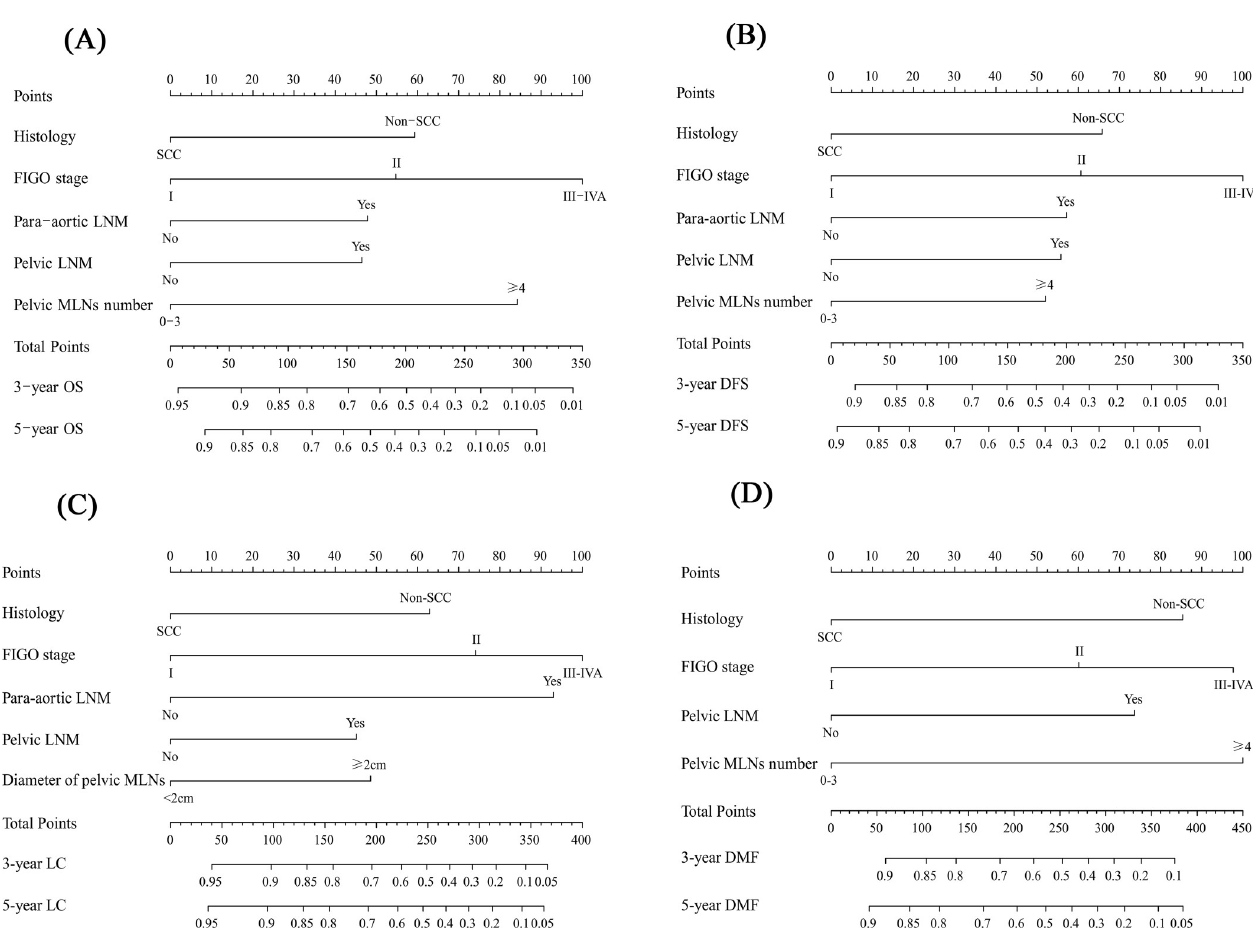
Fig 1. Nomogram for determining the 3- and 5-year overall survival (OS, Fig 1A), disease-free survival (DFS, Fig 1B), local control (LC, Fig 1C) and distant metastasis-free (DMF, Fig 1D) of patients with cervical cancer treated with chemoradiotherapy. FIGO = International Federation of Gynecology and Obstetrics; LNM = lymph nodes metastases; MLNs = metastatic lymph nodes; non-SCC = non-squamous cell carcinoma; SCC = squamous cell carcinoma.